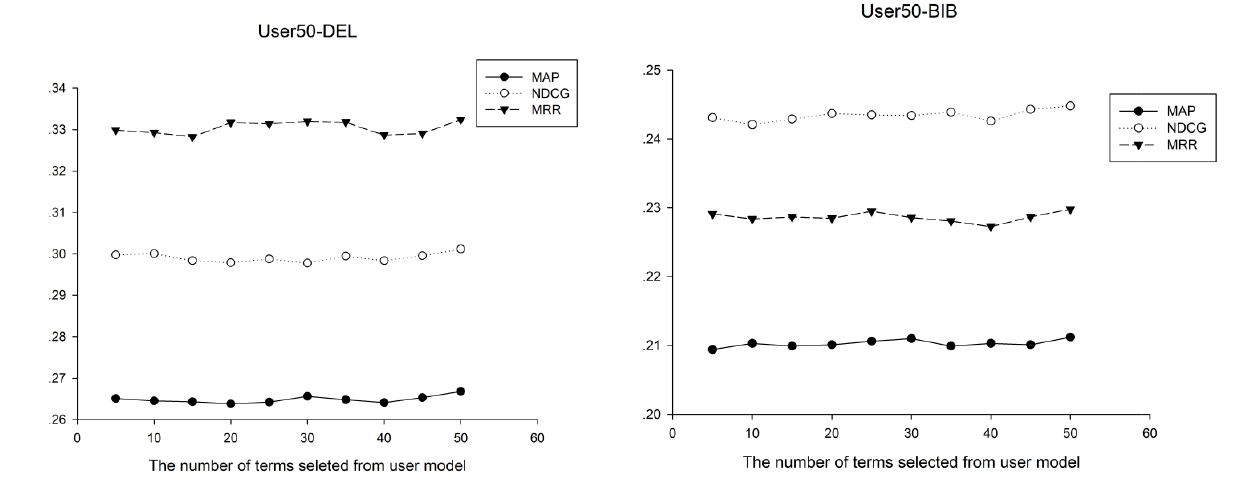
Fig. 6 . The performance by varying the number of terms selected from user model on two